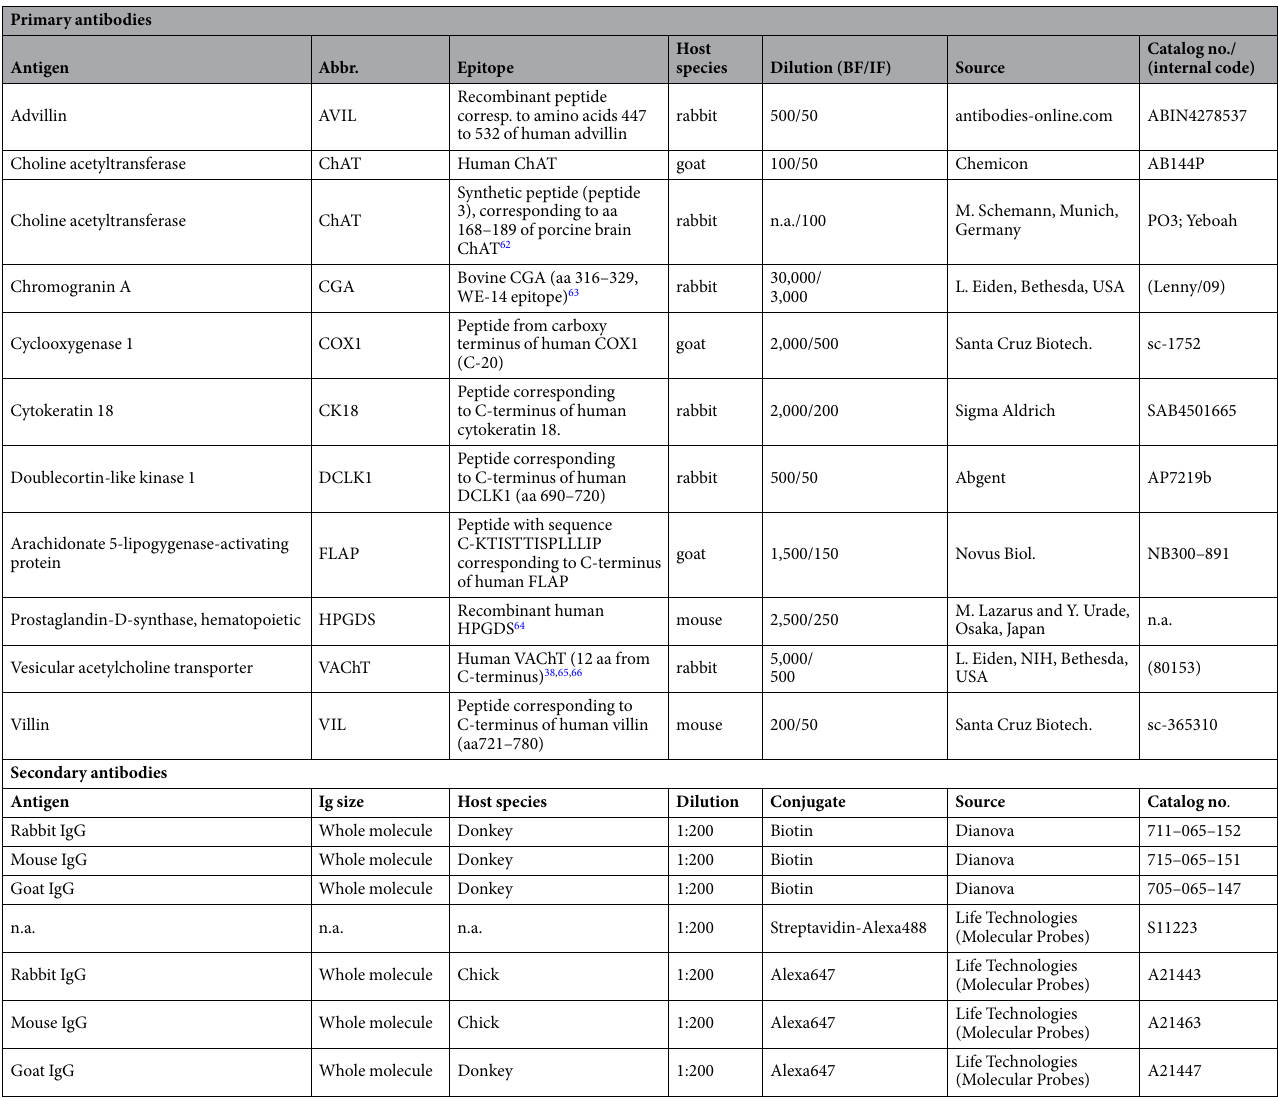
Table-1. Characteristics of primary and secondary antibodies used for immunohistochemistry. Abbr.: BF = brightfield, IF = immunofluorescence, n.a. = not applicable. Companies: Abgent, San Diego, CA, USA; Dianova, Hamburg, Germany; Life Technologies, Carlsbad, USA; Novus Biologicals, Centennial, CO, USA; Santa Cruz Biotechnologies Inc., Heidelberg, Germany; Sigma-Aldrich, St. Louis, MO, USA. Select